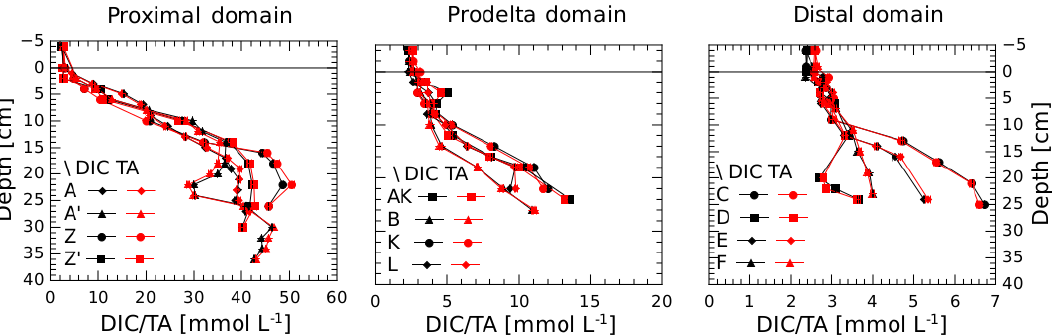
Figure 5. DIC (black) and TA (red) porewater profiles in the first 40cm of sediment in the proximal, the prodelta and the distal domains. For a better visibility of the profiles in each domain, the scale of the concentrations has been individually adjusted for each domain.